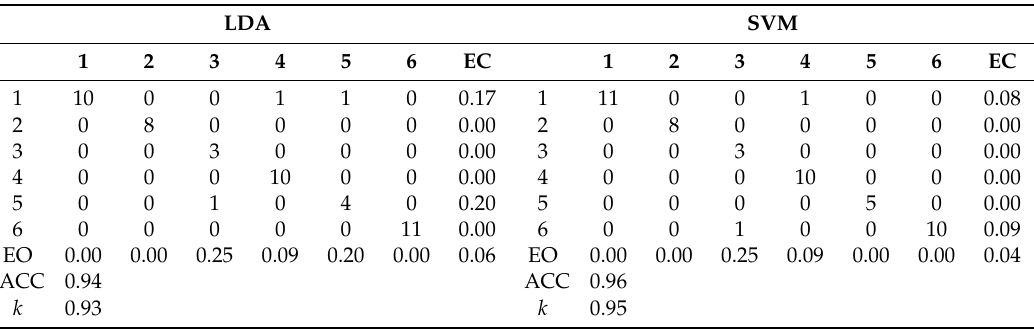
Table 1. Confusion matrix for the LDA and SVM models.